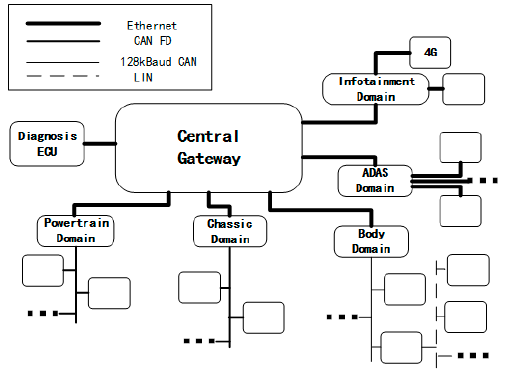
Figure 3. Ethernet serving as a backbone in vehicles.